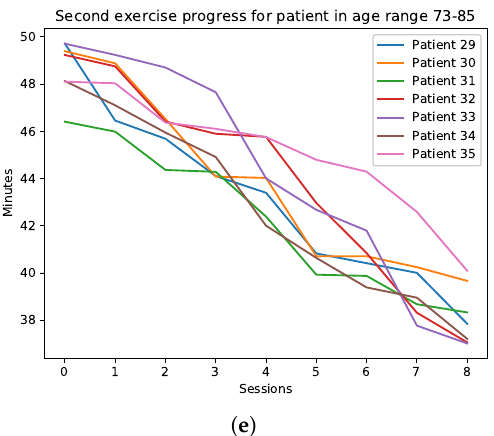
Figure 14. The performance of the patients for the fourth exercise. The plots are divided by age: ( a ) 25–36, ( b ) 37–48, ( c ) 49–60, ( d ) 61–72, ( e ) 73–85.